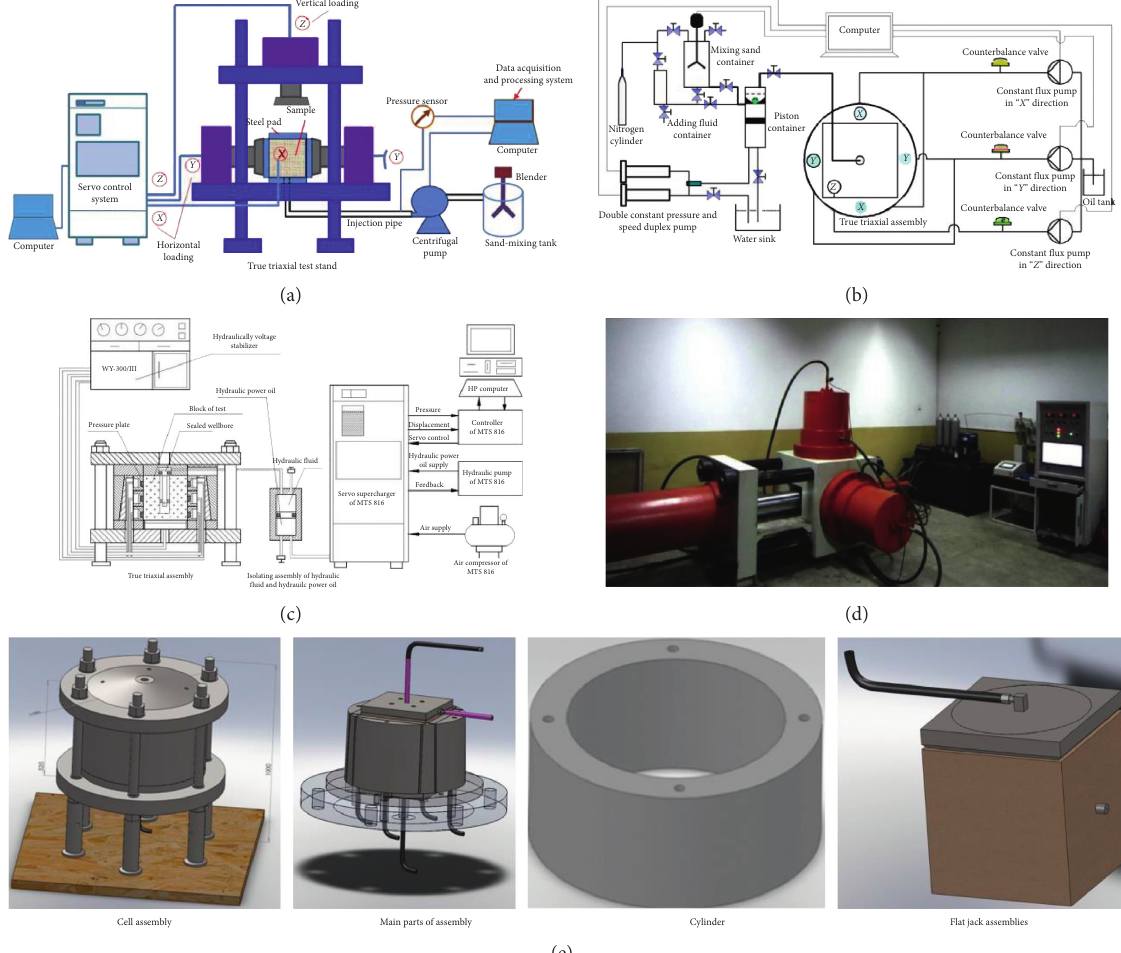
Figure 4: True triaxial type setups for hydraulic fracturing experiments in (a) Zhao et al. [18]; (b) Tan et al. [66]; (c) Zhang et al. [62]; (d) Guo et al. [69]; and (e) Zhang and Fan